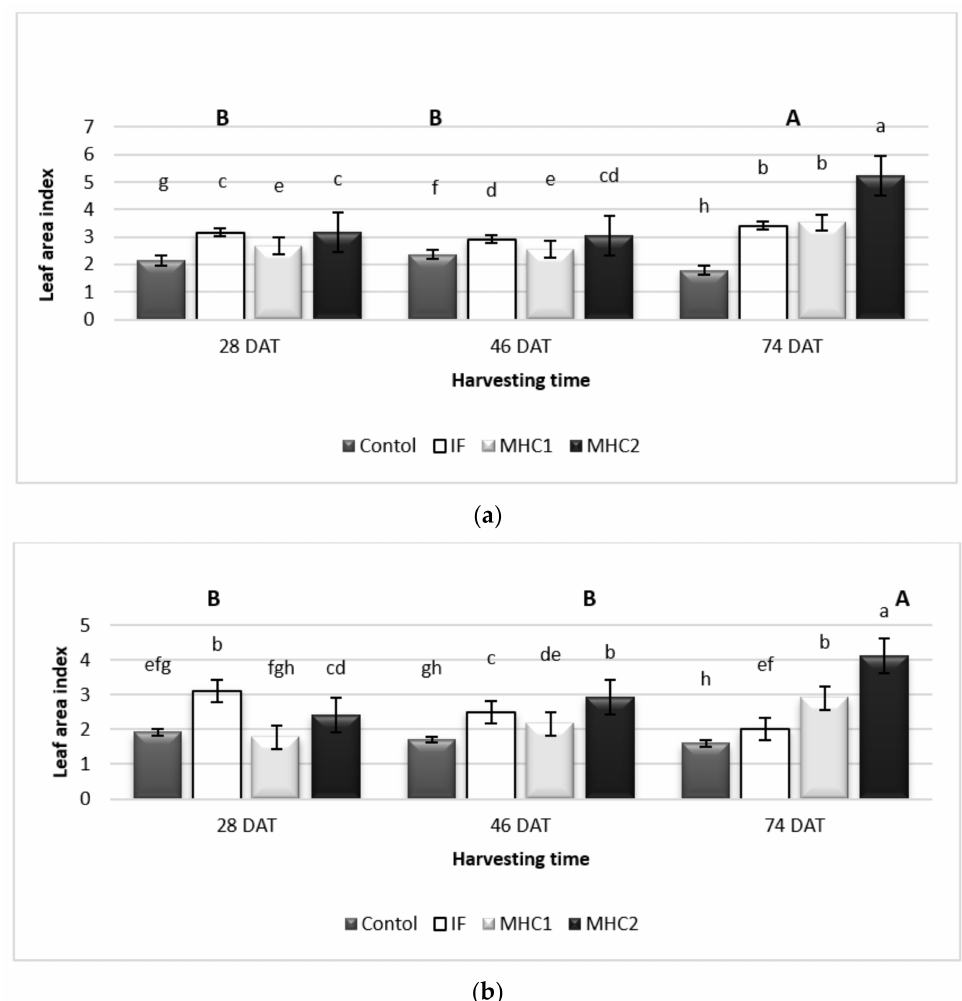
Figure 2. Effect of macadamia husk compost and inorganic on leaf area index during three harvest period, 28 DAT = Harvest 1, 46 DAT = Harvest 2, Harvest 3 = 74 DAT, in 2018 ( a ) and 2019 ( b ). Different small letters indicate significant differences between fertilizer levels and harvest time ( p < 0.01), and different capital letters indicate significant differences between harvest time ( p < 0.01 in 2018 and p < 0.05 in